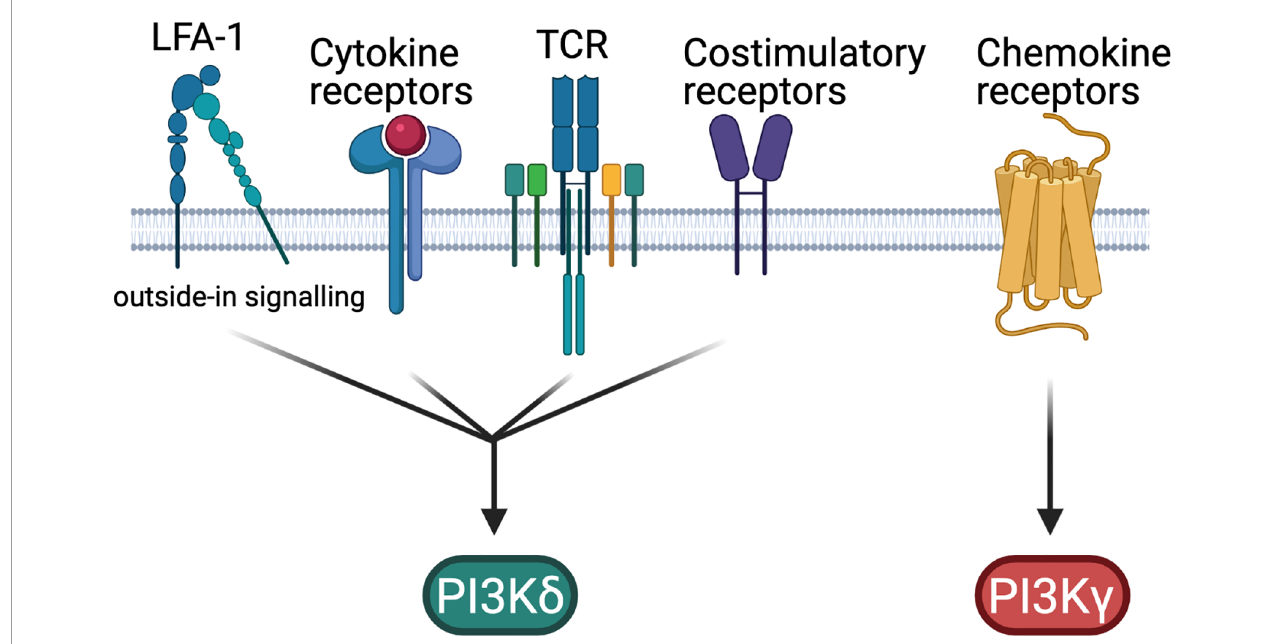
FIGURE 1 | PI3K activation in T cells. Simpli fi ed schematic of the differential regulation of PI3K d and PI3K g in T cells. Figure made in